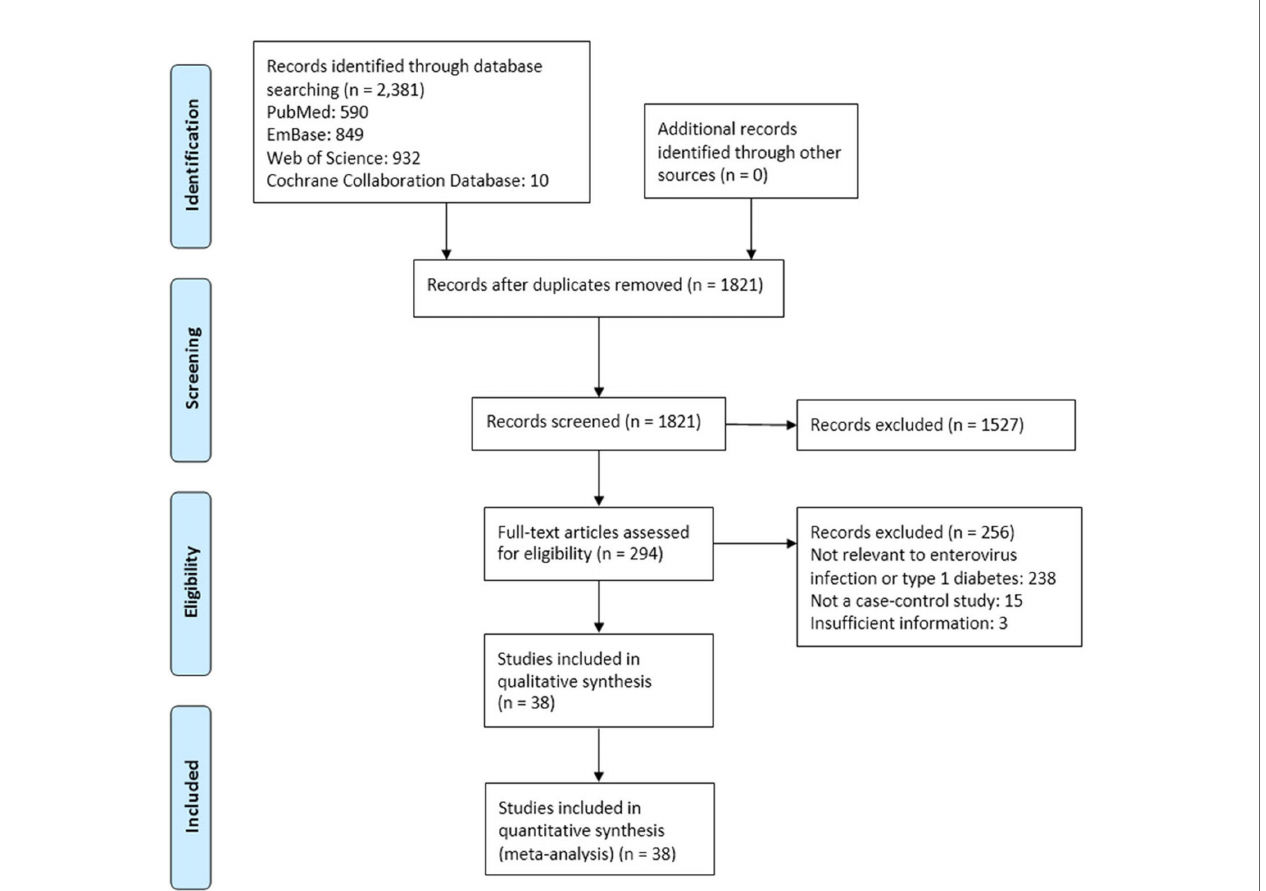
FIGURE 1 | Schematic of the process of selecting studies for the